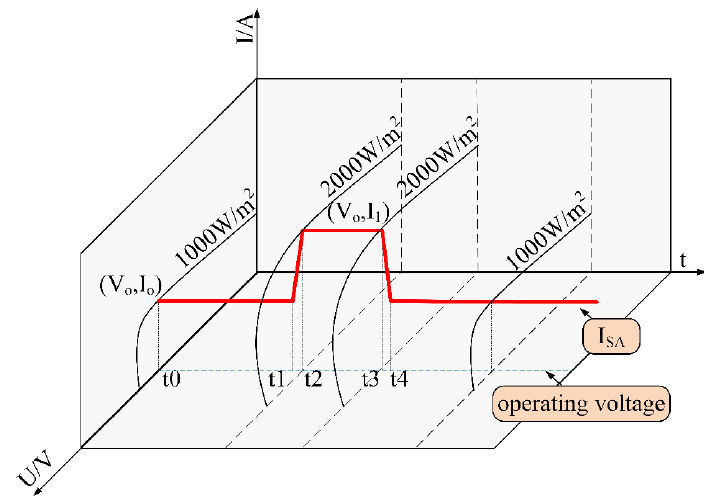
Figure 7. Waveform of output current changing with light intensity.